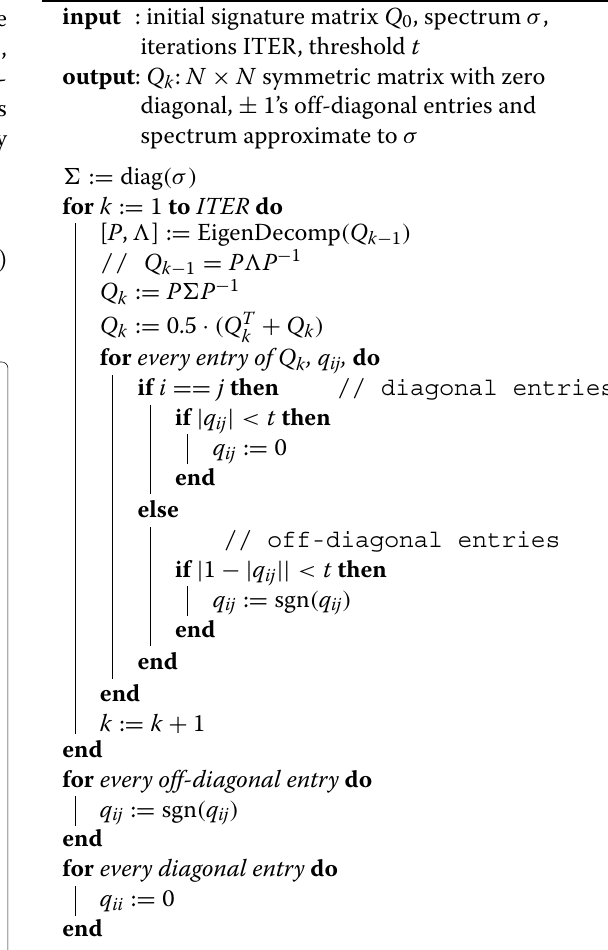
Algorithm 2: Signature matrix construction